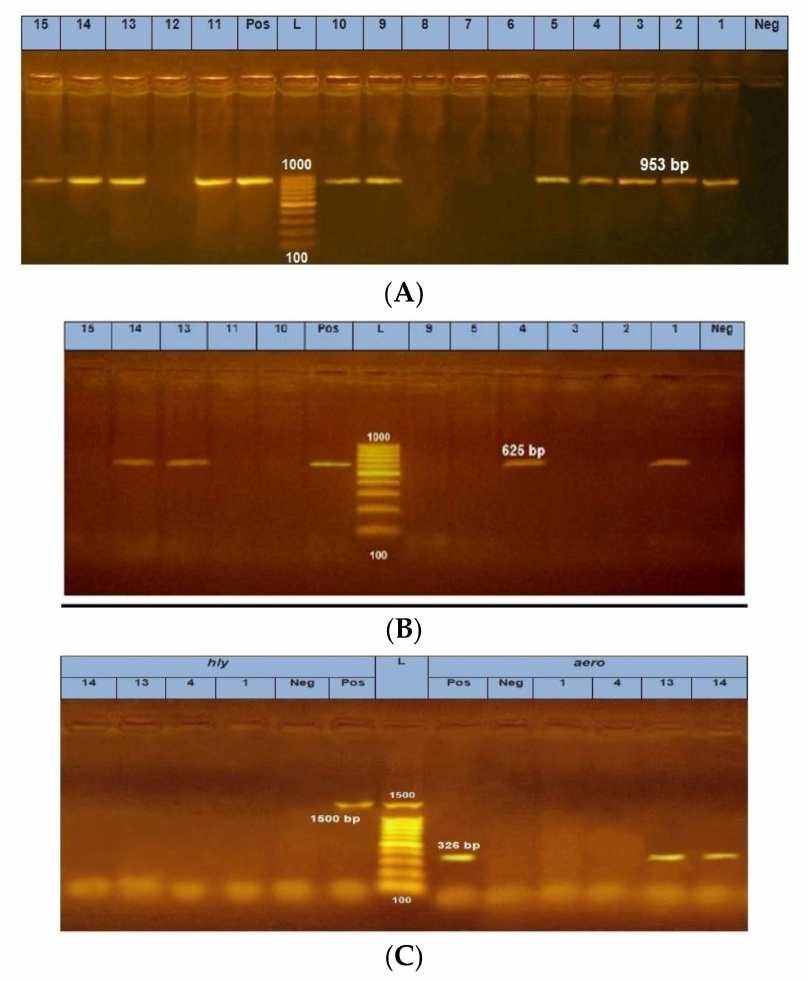
Figure 2. ( A ) Representation of polymerase chain reaction (PCR) positives for 16S rRNA of the genus Aeromonas with an amplicon size of 953 bp. L: 100 bp ladder; lanes 1–5, 9–11, and 13–15: positive samples; lanes 6–8 and 12: negative samples; lane Pos: positive control. ( B ) Representation of polymerase chain reaction (PCR) positives for 16S rRNA of genus Aeromonas hydrophila with an amplicon size of 625 bp. L: 100 bp ladder; lanes 1, 4, 13, and 14: positive samples; lanes 2, 3, 5, 9, 10, 11, and 15: negative samples; lane pos: positive control; lane neg: negative control. ( C ) Representation of polymerase chain reaction (PCR) positives for 16S rRNA of aer and hly gene amplification of Aeromonas hydrophila isolates. L: 100 bp ladder; for the aer gene lanes (13 and 14): positive samples. Lane (1 and 4): negative sample. Lane Pos: positive control and lane Neg: negative control. For the hly the, lanes 1, 4, 13, and 14: negative samples. Lane Pos: positive control and lane Neg: negative